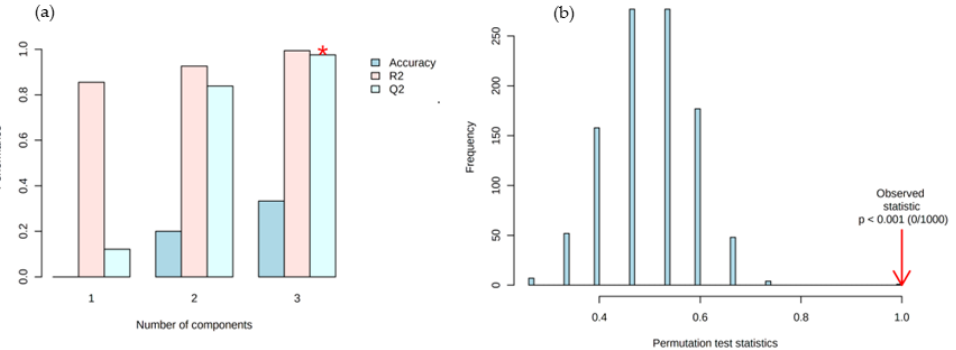
Figure 6. ( a ) 10-fold cross-validation performance and ( b ) model validation by permutation test based on 1000 permutations of VOCs obtained by GC-MS of spent coffee grounds samples (* means best Q2